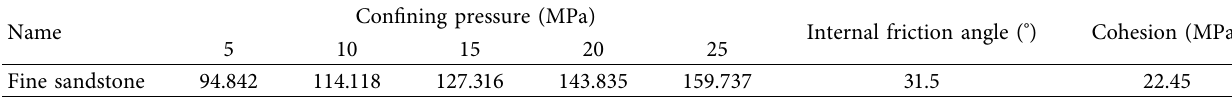
Table 4: Triaxial compression test results of fine sandstone specimens under different confining pressures.